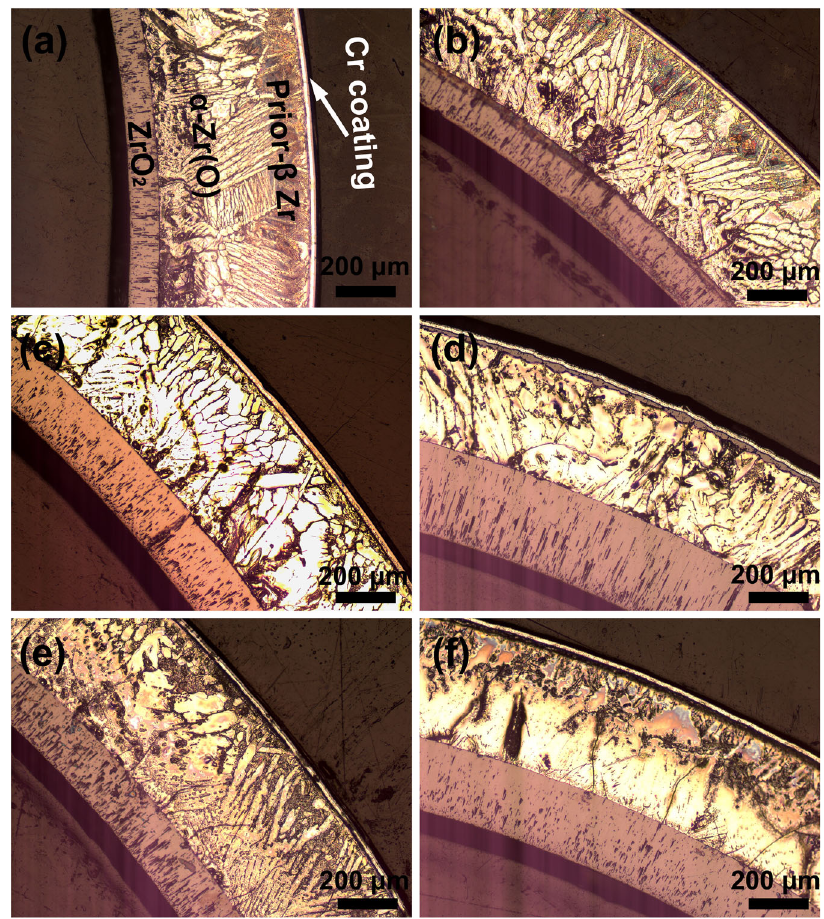
Fig. 2 Optical micrographs of the Cr-coated Zr tube oxidized at different conditions. a 1200 o C/0.5 h, b 1200 o C/1 h, c 1200 o C/2 h, d 1200 o C/4 h, e 1300 o C/0.5 h, f 1300 o C/1